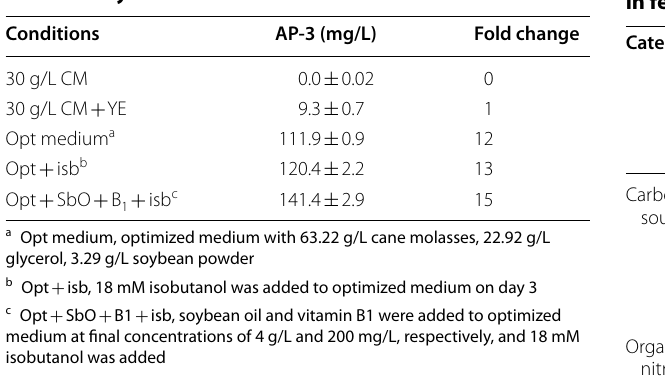
Table 4 Summary of improvements in AP-3